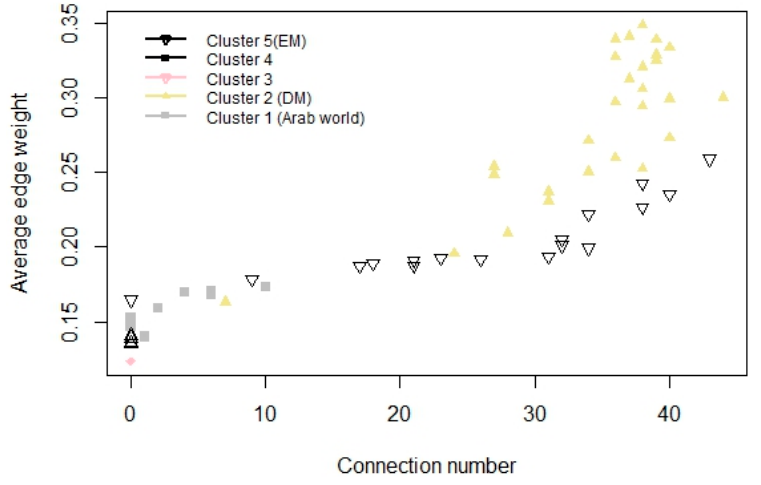
Figure 14. Cluster-wise connection number and average connection strength.